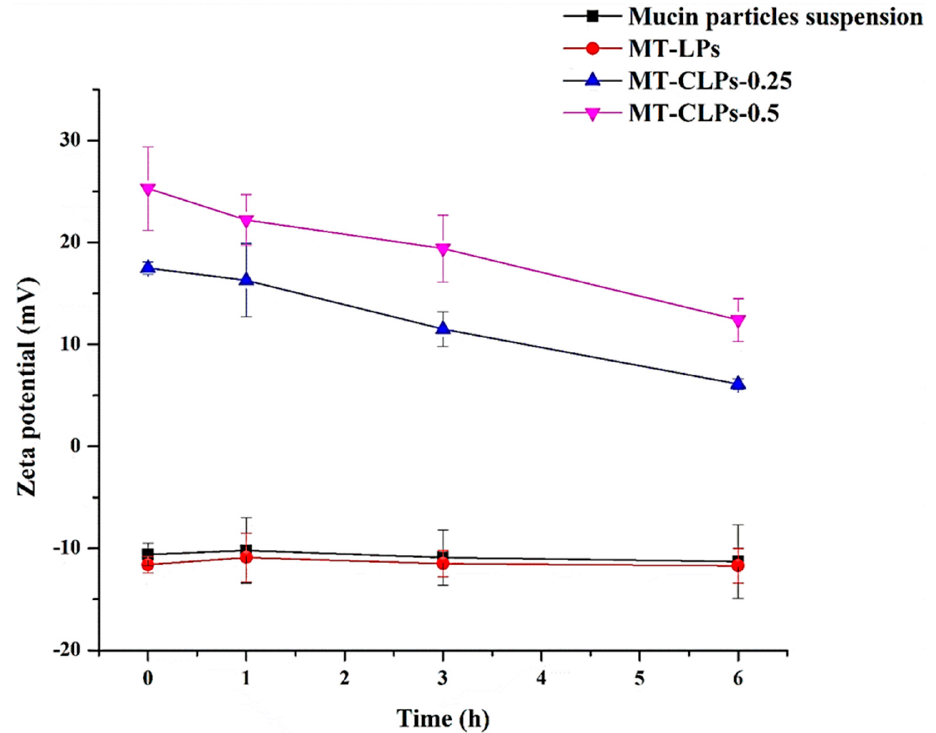
Figure 4. The zeta potential values of MT-LPs, MT-CLPs-0.25, and MT-CLPs-0.5 during incubation in 0.1% mucin dispersion (mean ± SD, n = 3).